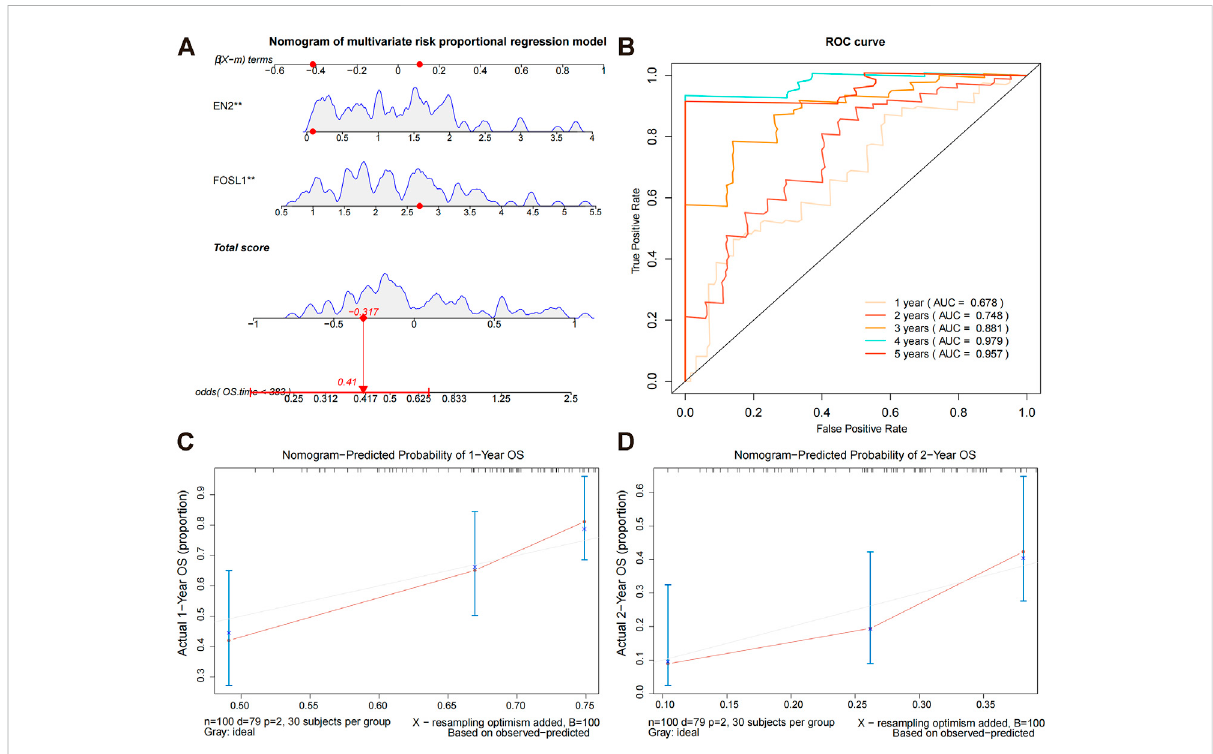
FIGURE 4 Constructing a nomogram prediction model. (A) Nomogram prediction model for prognostic risk. (B) Time-dependent ROC curves for the overall survival of the training set. During the fi rst, second, third, and fourth years, AUC values were evaluated. (C,D) Calibration curves for predicting the overall survival of the training set at 1 and 2